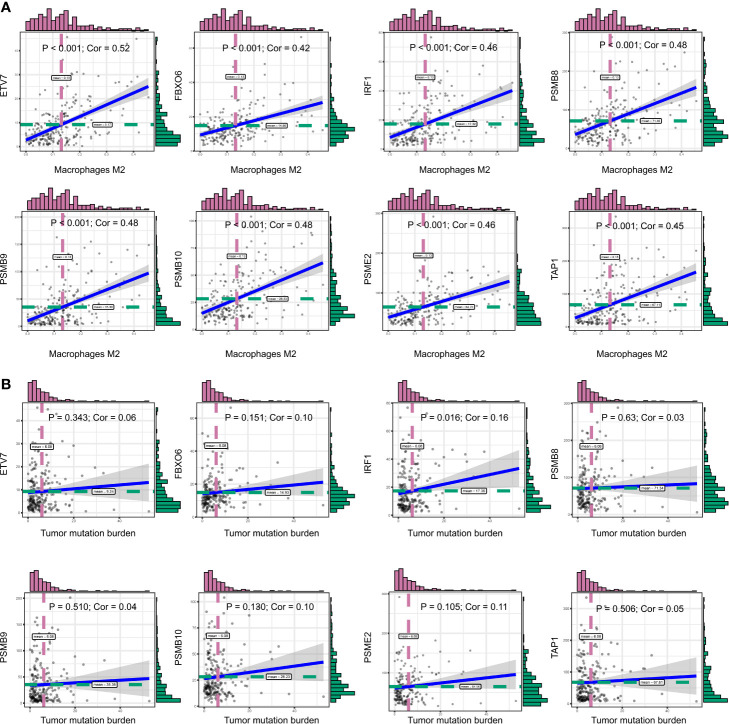

(A) The correlation between co-expression genes and CD8+ T cells proportion. (B) The correlation between co-expression genes and tumor mutation burden (TMB).